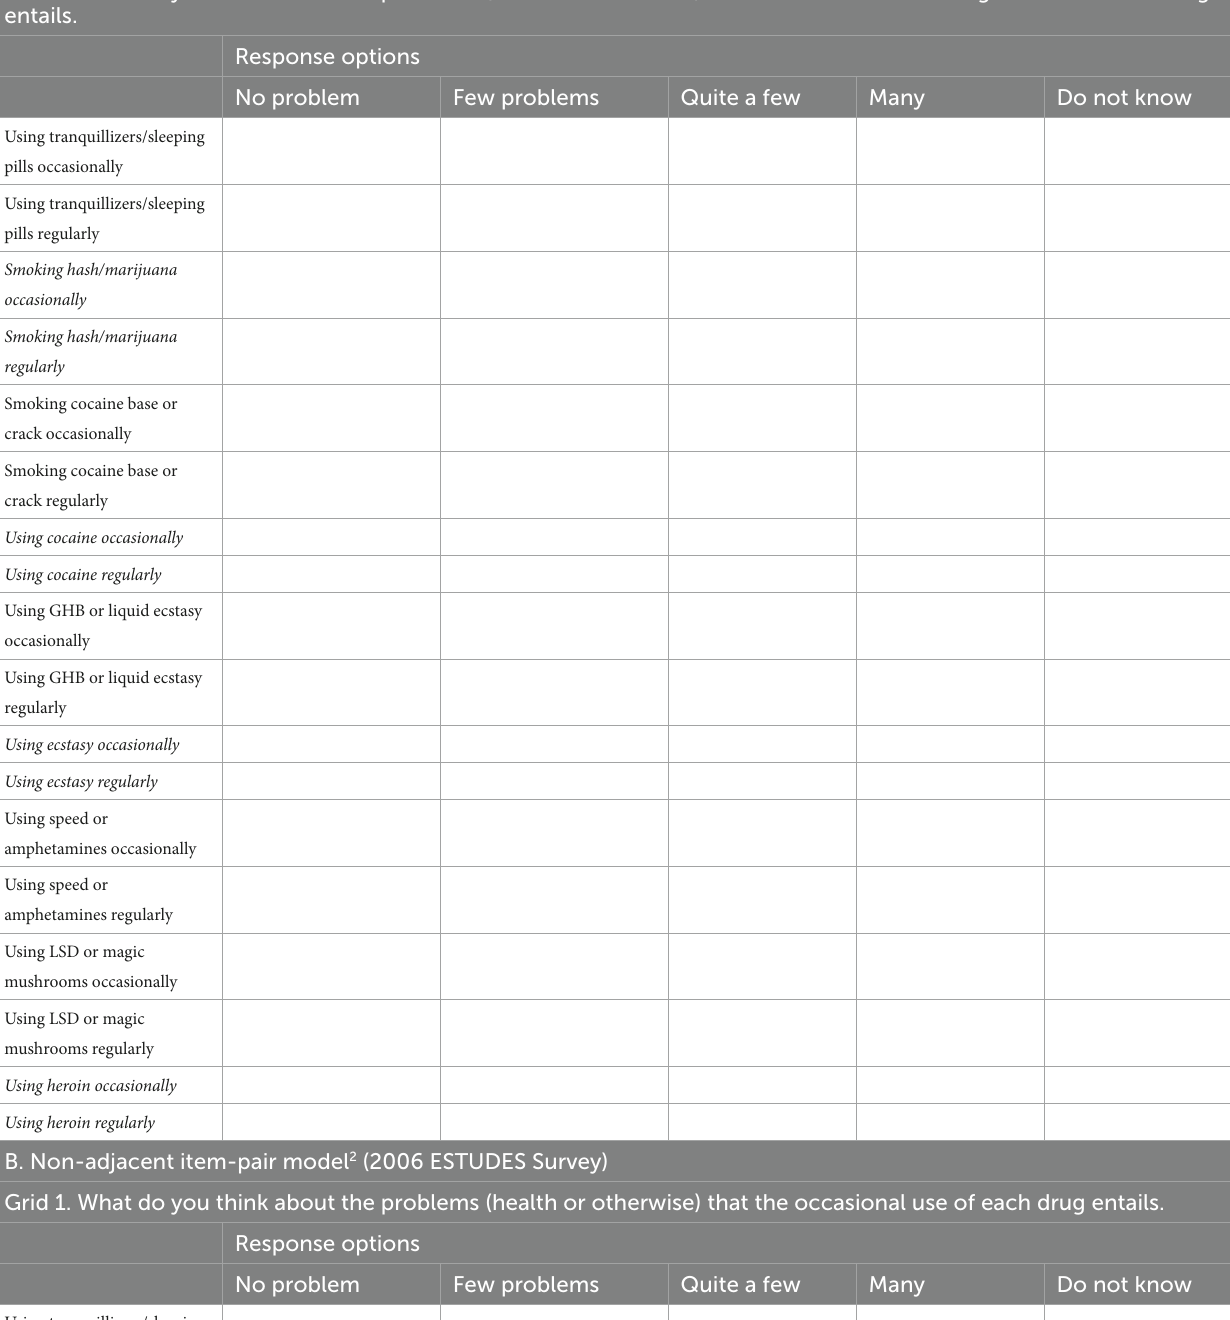
TABLE 1 Questionnaire models on perceived risk of drug use included in ESTUDES survey (Spain, 2000–2012). A. Adjacent item-pairs model 1 (ESTUDES Surveys before and after 2006) Grid 1. What do you think about the problems (health or otherwise) that the occasional and regular use of each drug